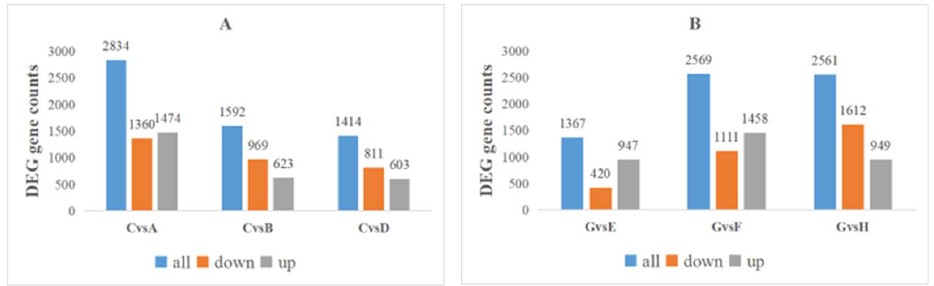
Figure 7. Venn diagram of differentially expressed genes. ( A ): Venn diagram at 64 DAB. ( B ): Venn